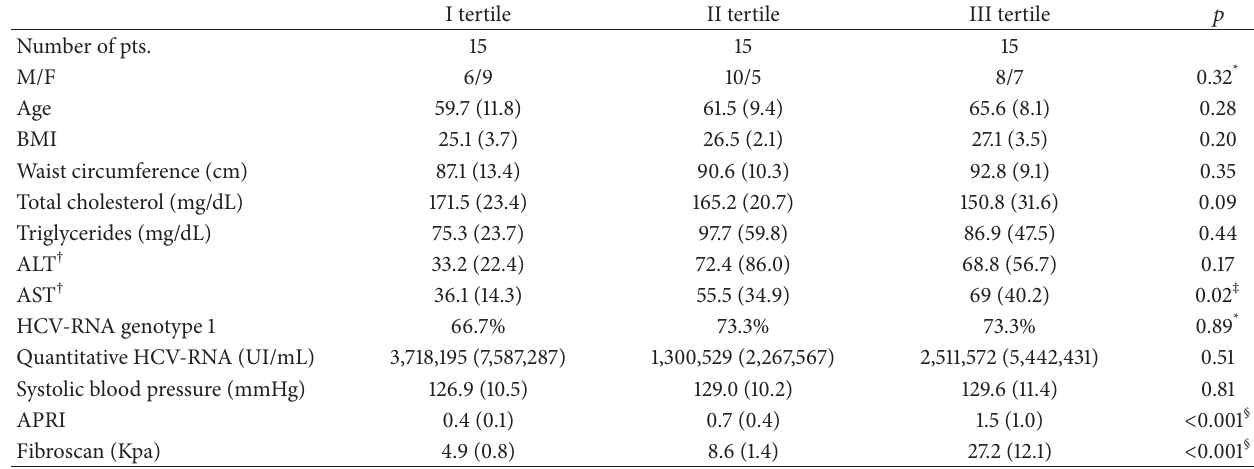
Table 1: Demographic, serological, and anthropometric parameters, systolic blood pressure, and stage of fibrosis assessed by fibroscan and APRI, in the 3 tertiles. I tertile II tertile III tertile 𝑝 Number of